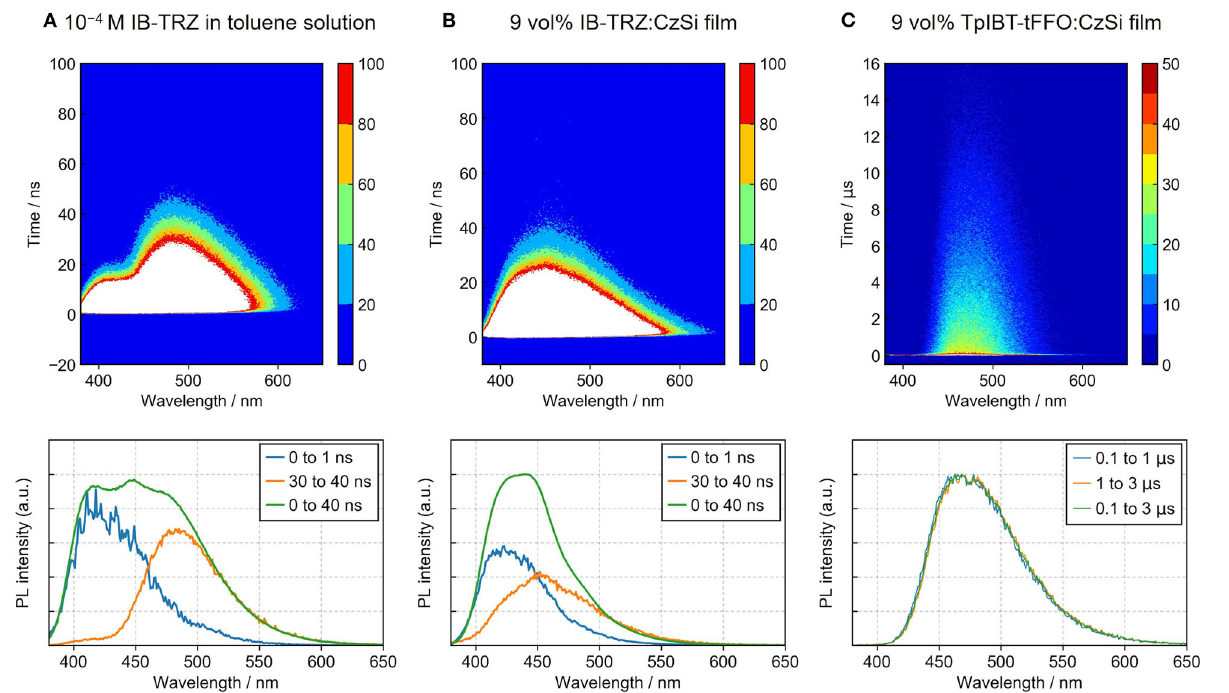
Frontiers in Chemistry |